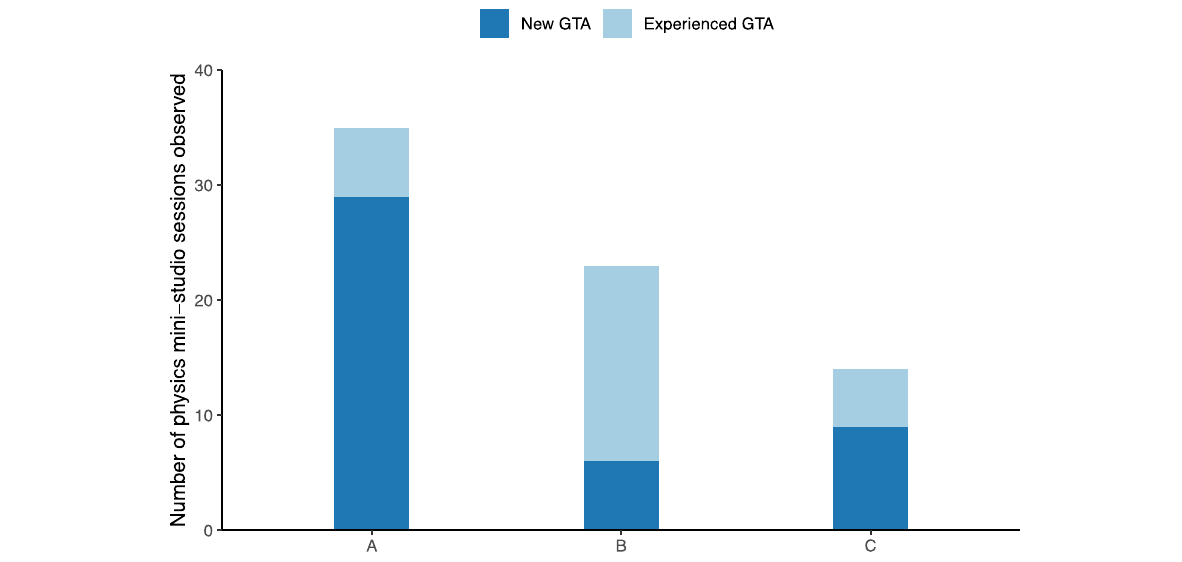
Fig. 8 Number of physics combined tutorial and laboratory sessions in each cluster led by new GTAs and experienced